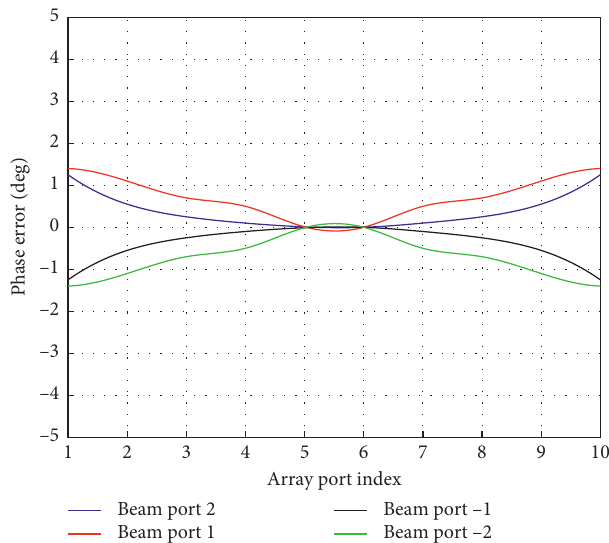
Figure 8: S-band Rotman lens: phase errors at the array